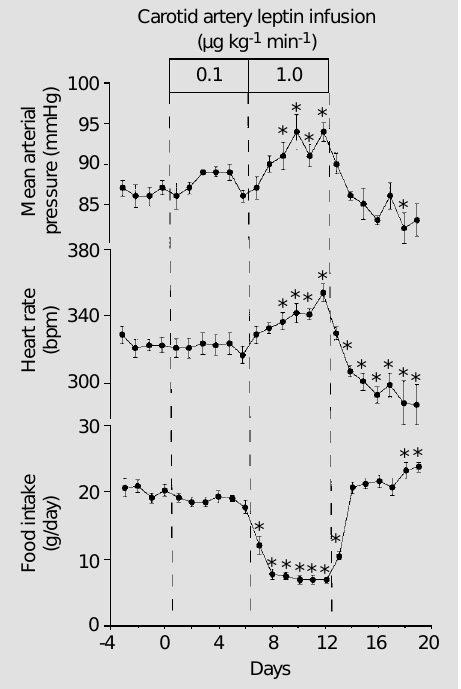
Figure 7 - Effect of bilateral ca- rotid artery infusion of leptin at 0.1 µg kg -1 min -1 (5 days) and 1.0 µg kg -1 min -1 (7 days) on mean arterial pressure, heart rate, and daily food intake in con- scious normal Sprague-Dawley rats. *P<0.05 compared to con- trol. (Redrawn from Ref. 53).